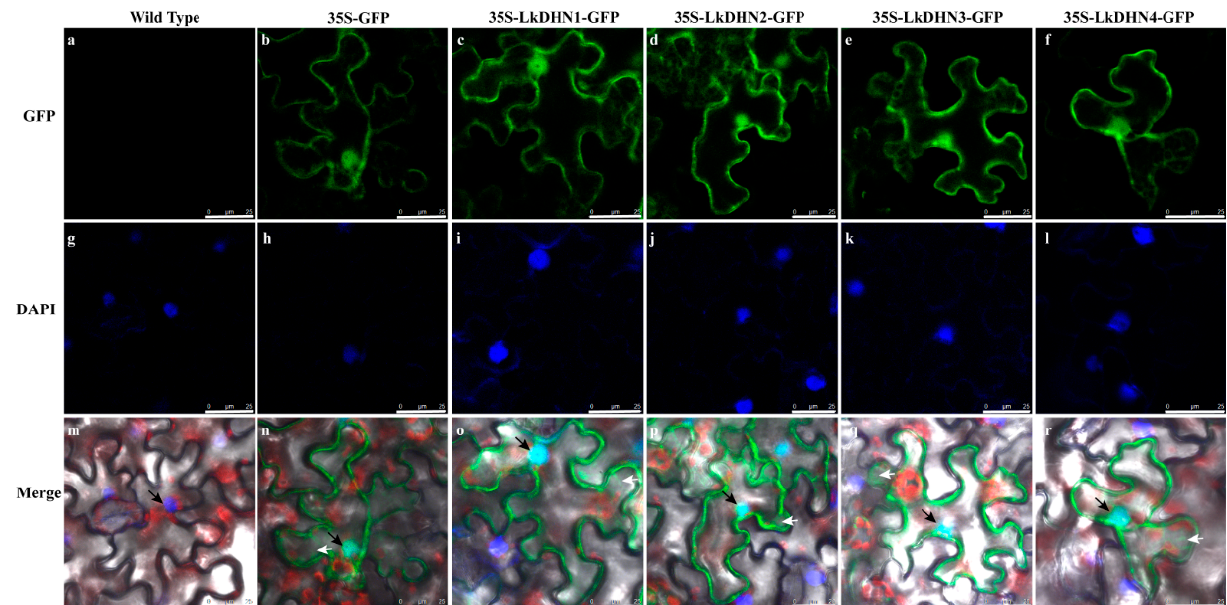
Figure 2. Subcellular localization of LkDHNs in lower epidermis cells of the transformed tobacco leaves. ( a – f ) are wild type, 35S-GFP, 35S-LkDHN1-GFP, 35S-LkDHN2-GFP, 35S-LkDHN3-GFP, and 35S-LkDHN4-GFP at the wavelength of GFP, respectively; ( g – l ) are wild type, 35S-GFP, 35S-LkDHN1-GFP, 35S-LkDHN2-GFP, 35S-LkDHN3-GFP, and 35S-LkDHN4-GFP at the wavelength of DAPI, respectively; ( m – r ) are the merge of wild type, 35S-GFP, 35S-LkDHN1-GFP, 35S-LkDHN2-GFP, 35S-LkDHN3-GFP, and 35S-LkDHN4-GFP, respectively. The nucleuses were indicated by black arrow; the cytoplasms were indicated by white arrow. The scale bar is 25 μ m.